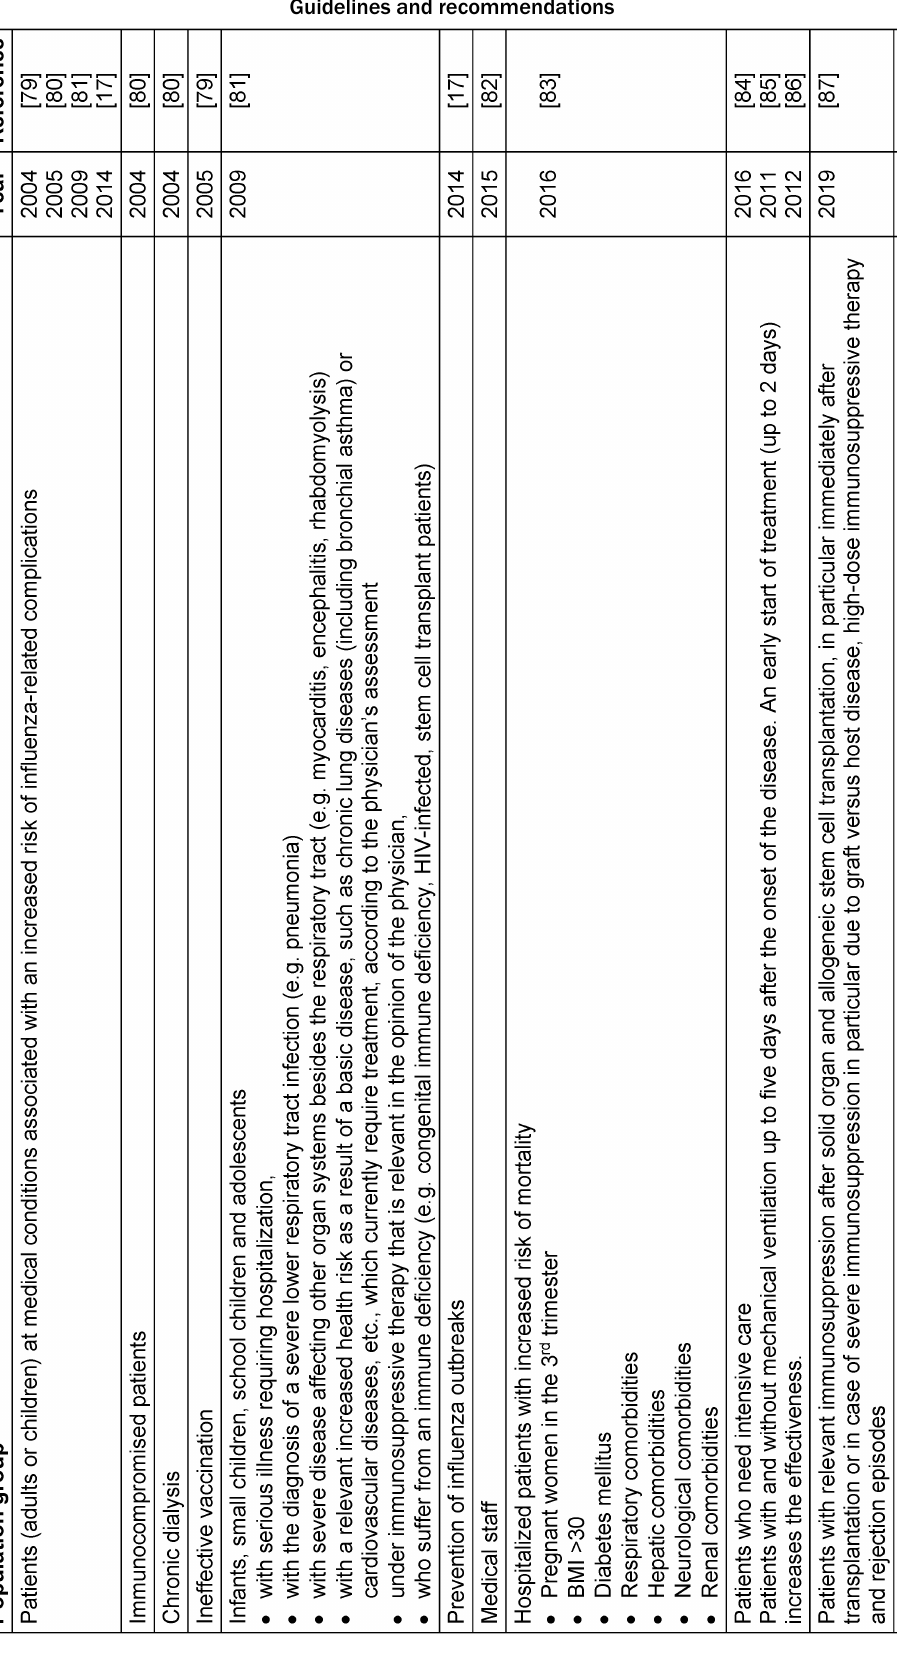
Table 2: Treatment recommendations for treatment of suspected and/or laboratory-confirmed influenza available from